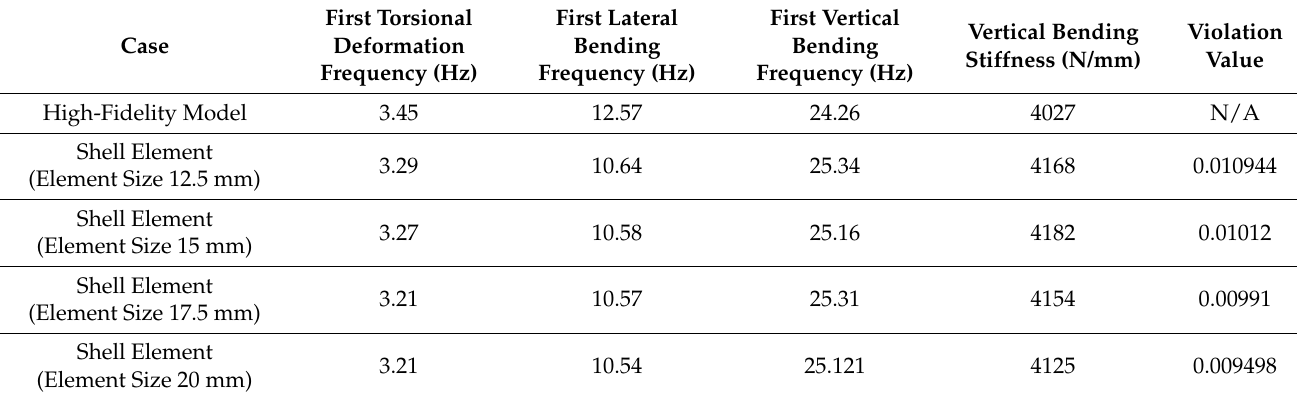
Table 1. Comparison of high-fidelity and medium-fidelity modal